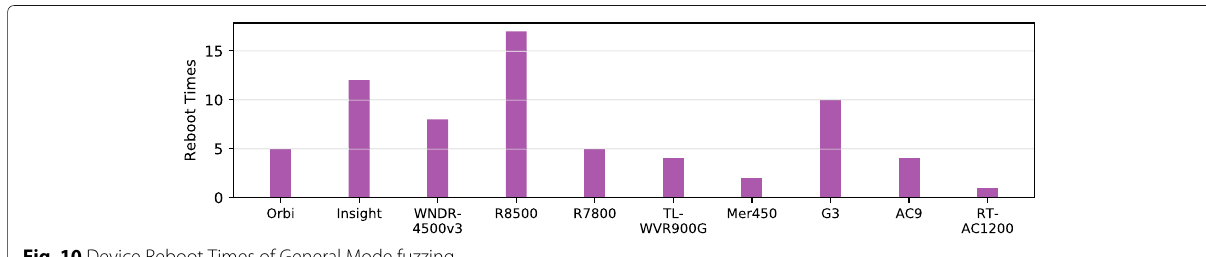
Fig. 10 Device Reboot Times of General Mode fuzzing